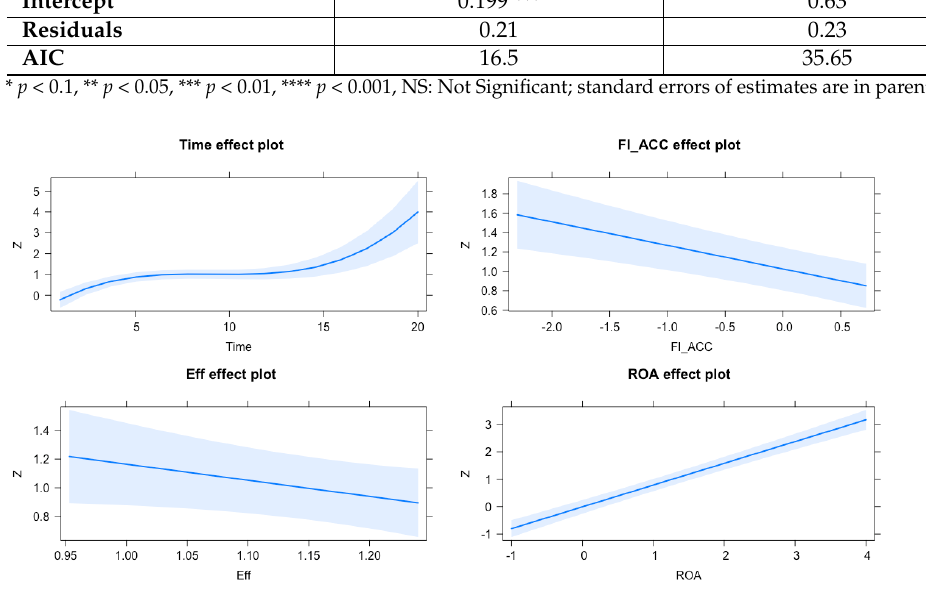
Figure 3. Significant factor effect plots for Islamic banks.